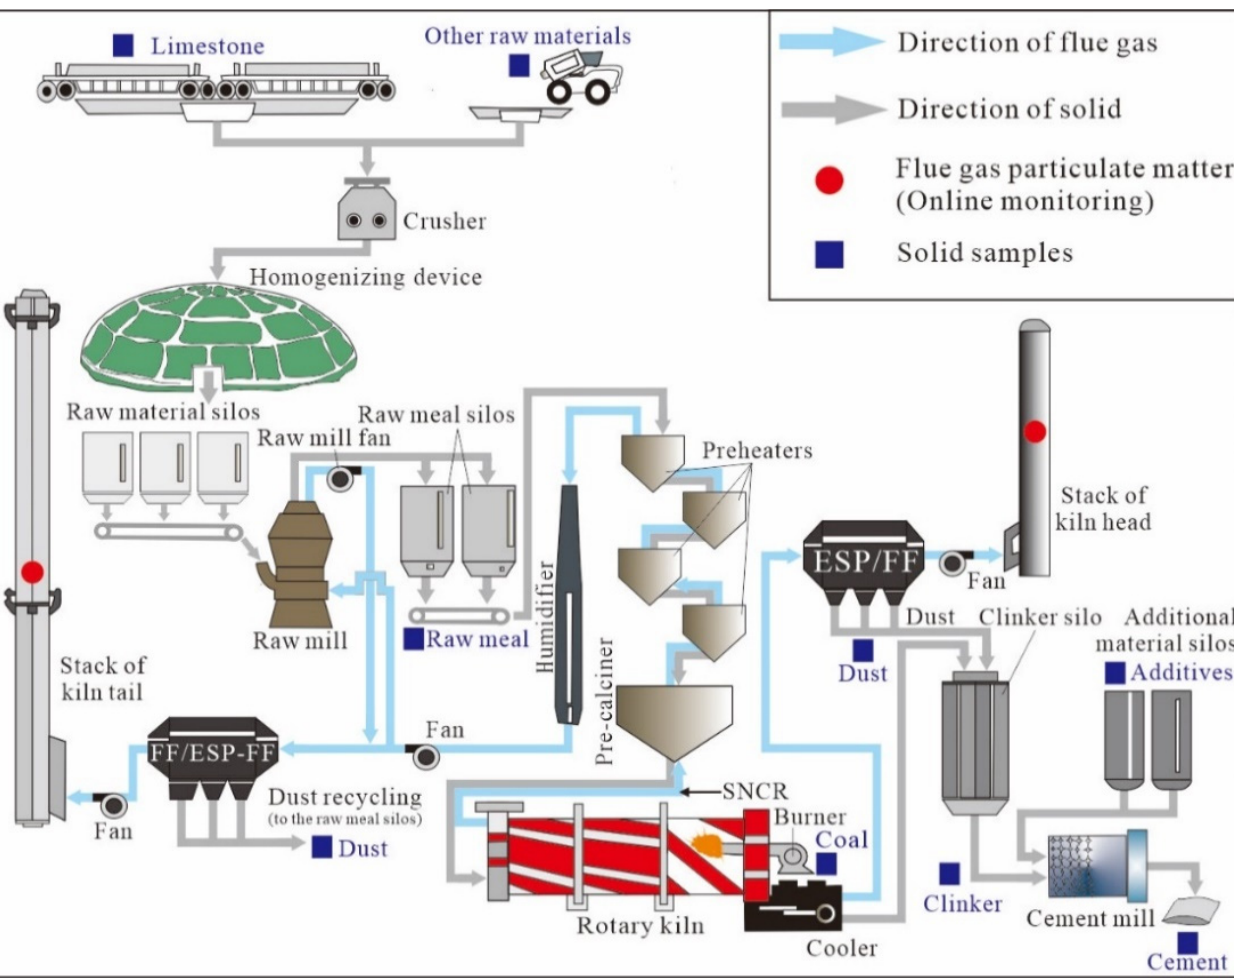
Figure A1. Overview of the cement manufacturing facilities and the sampling site locations.